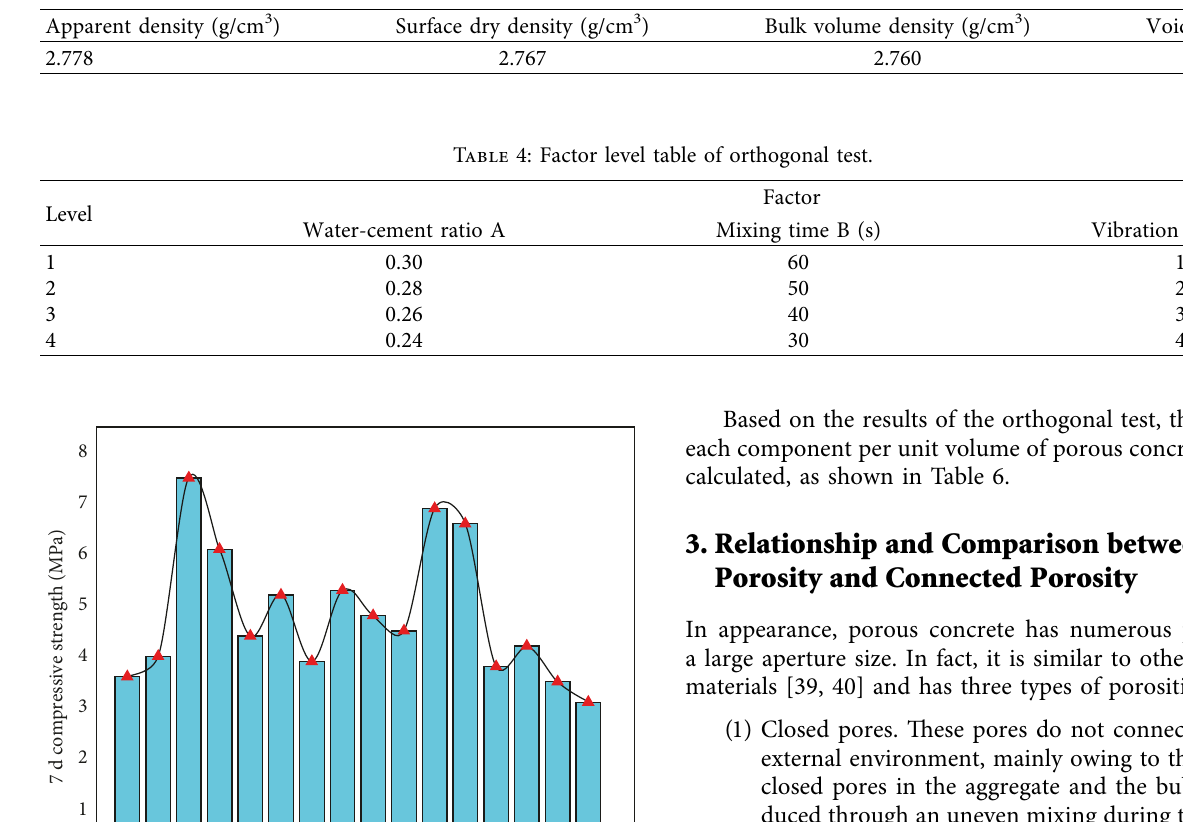
Table 3: Characteristics of mixed aggregate of porous